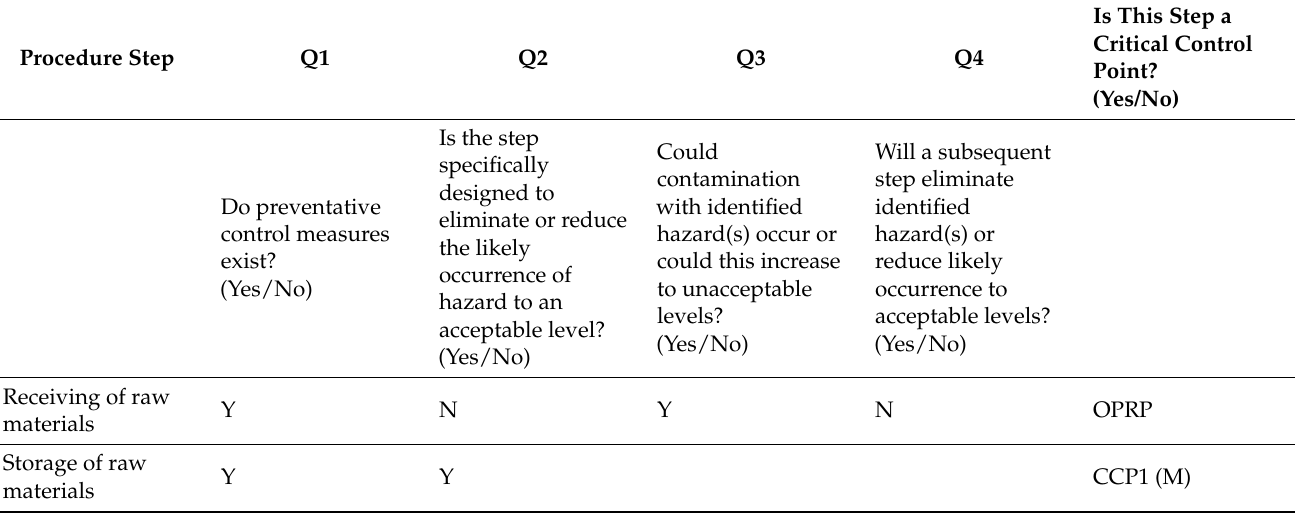
Table 4. Tree diagram for CCP and OPRP detection in food processing for a featured/representative production step according to decision of European Commission (2016/C 278/01)